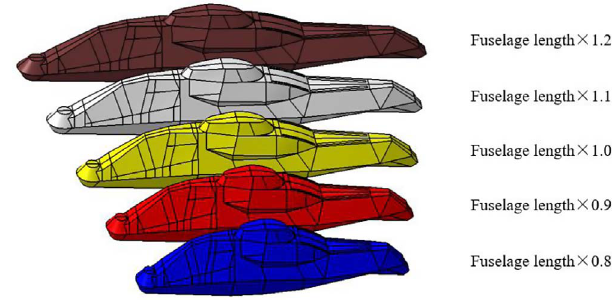
Figure 16. Fuselages with different length ratios.